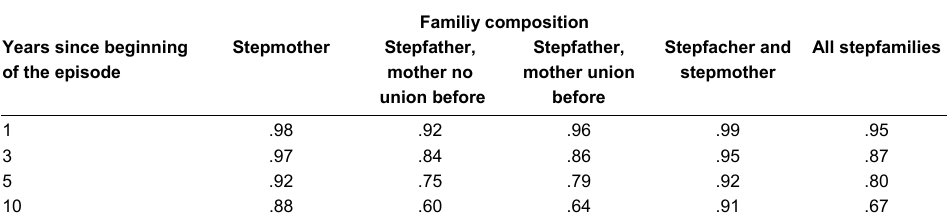
Table 2: Life tables estimates of the proportion of first stepfamily episodes ongoing at various durations, according to family